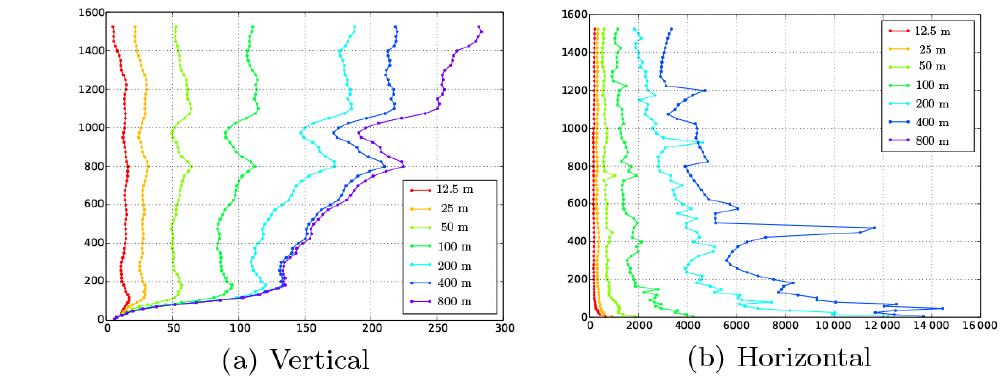
Figure 4. (a) Vertical and (b) horizontal mixing lengths computed at resolutions from 12.5 to 800m. CASES-99 (neutral